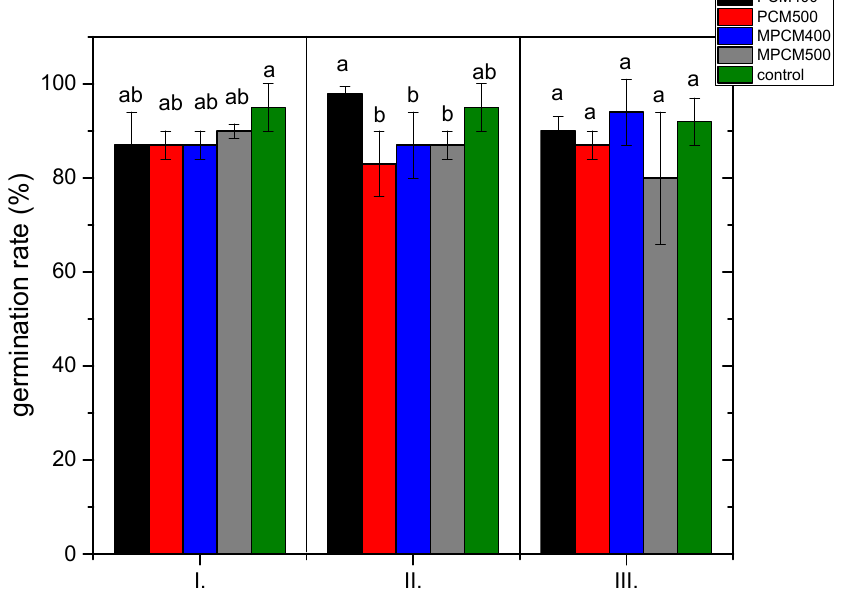
Figure 3. Germination rate (%) of cress seeds tested in volatile compounds only (I), leachable and volatile compounds (II), leachable, volatile compounds and direct contact with pyrolysis products (III). Germination rate is given as average value with standard deviation. Different letters mean statistically significant difference ( p < 0.05) of germination rate between treatments in each environ- ment.